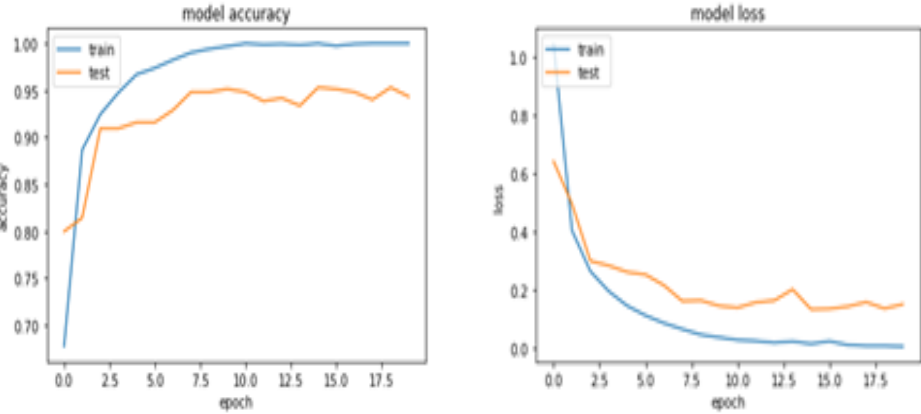
Figure 3. Proposed model’s accuracy and loss performance curves for both training and validation.